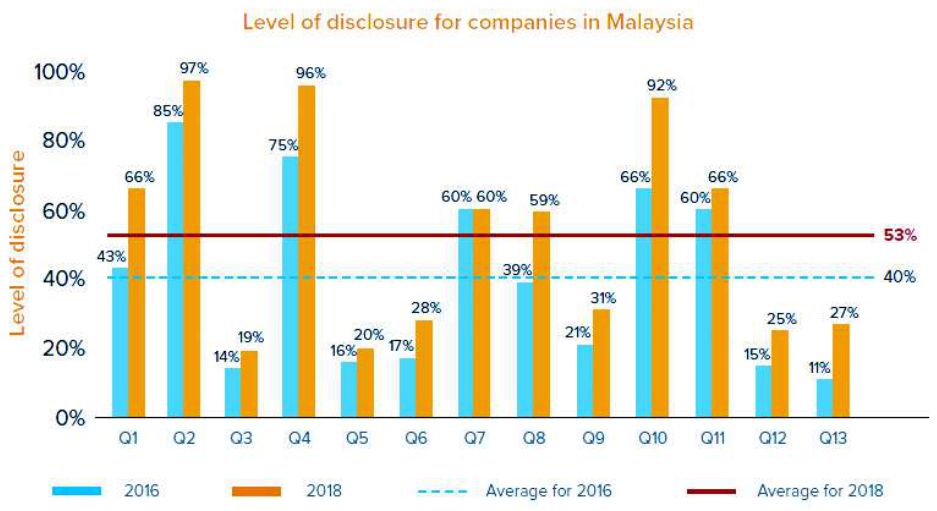
Source: Loh, Thao, Lee, and Thomas